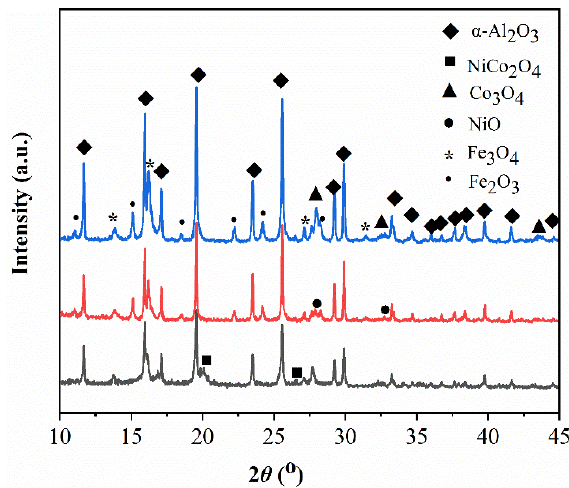
Figure 4. XRD of fresh Co/ α –Al 2 O 3 , Ni/ α –Al 2 O 3 , and NiCo/ α –Al 2 O 3 catalysts.